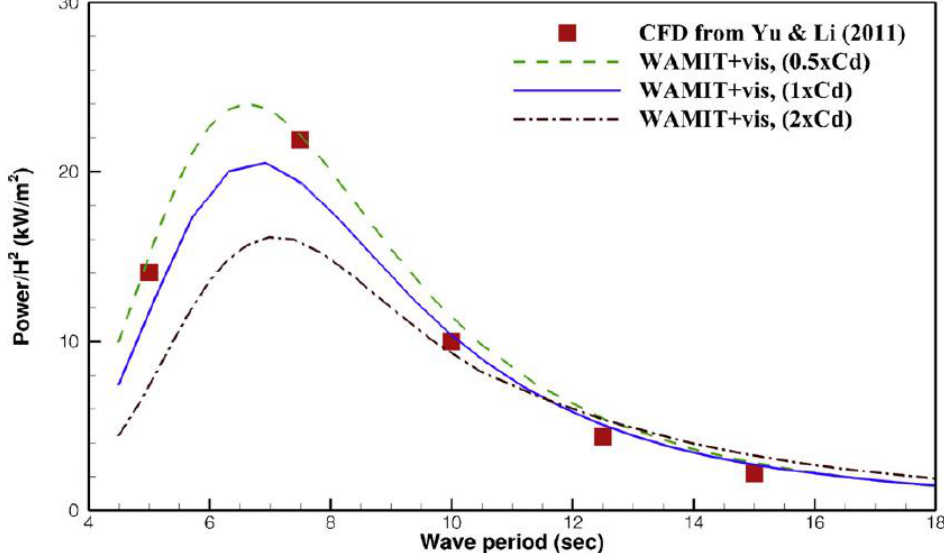
Figure 1. Captured power of a point absorber WEC vs. wave period calculation using different numerical methods [15]